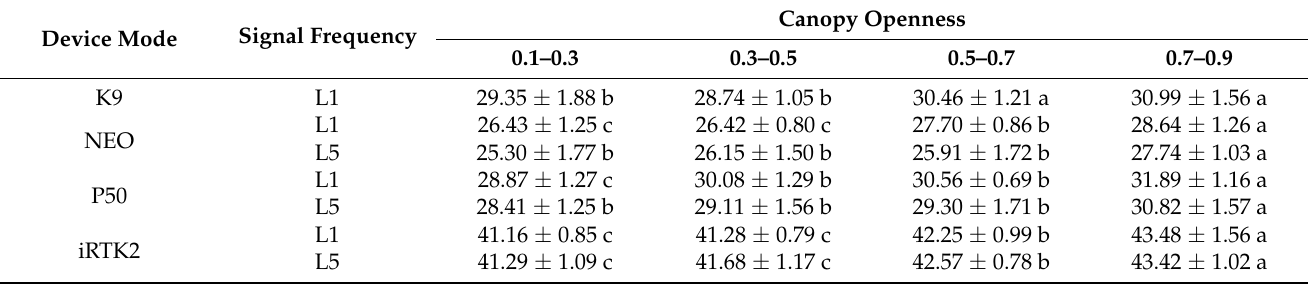
Table 3. C/N0 of each device at different openness.